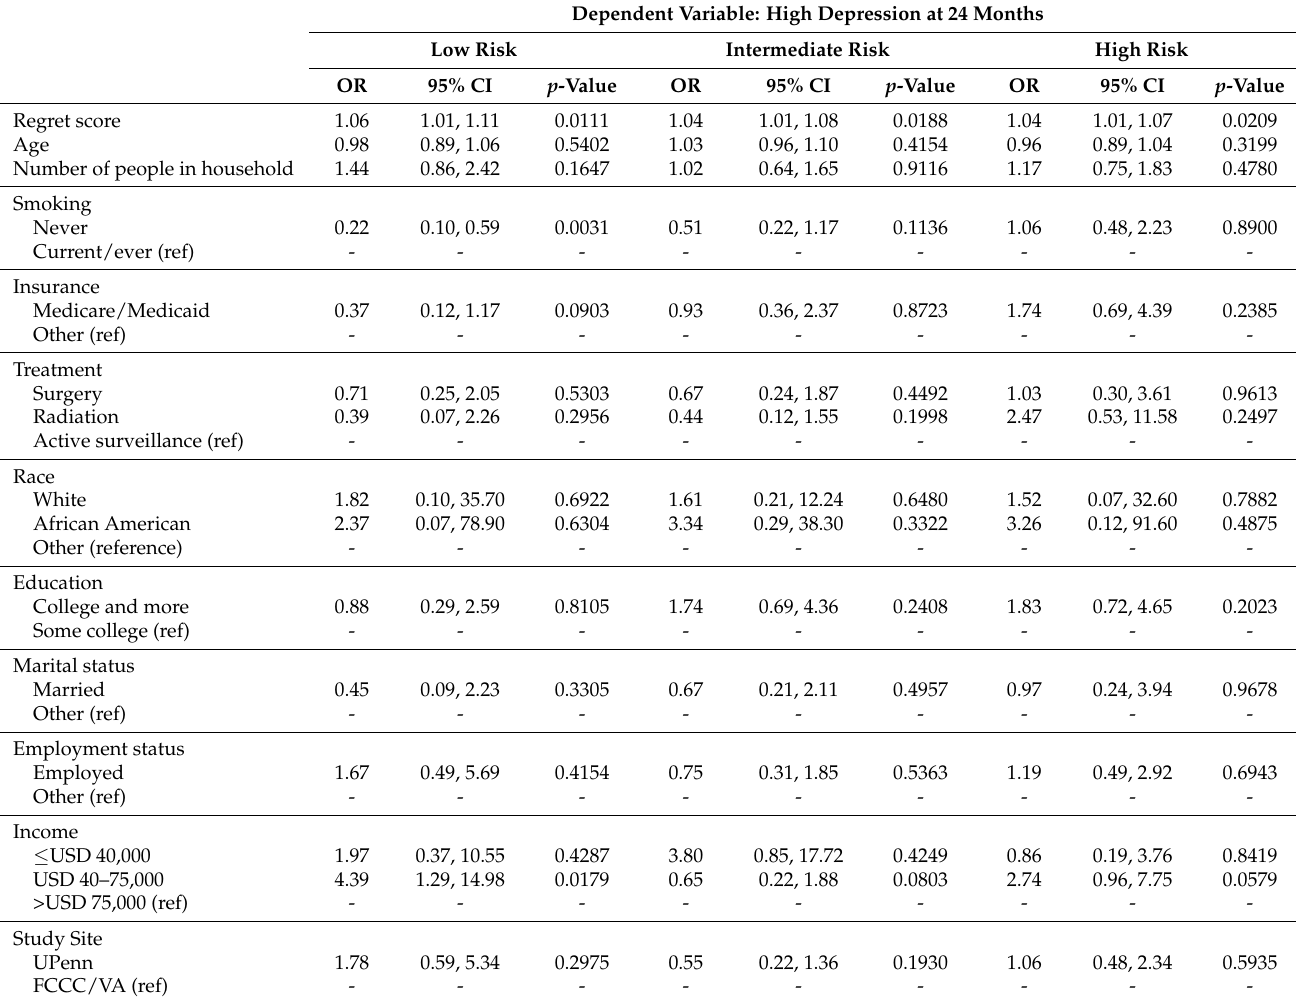
Table 3. Multivariable logistic regression for association between 24-month depression and regret, by prostate cancer risk